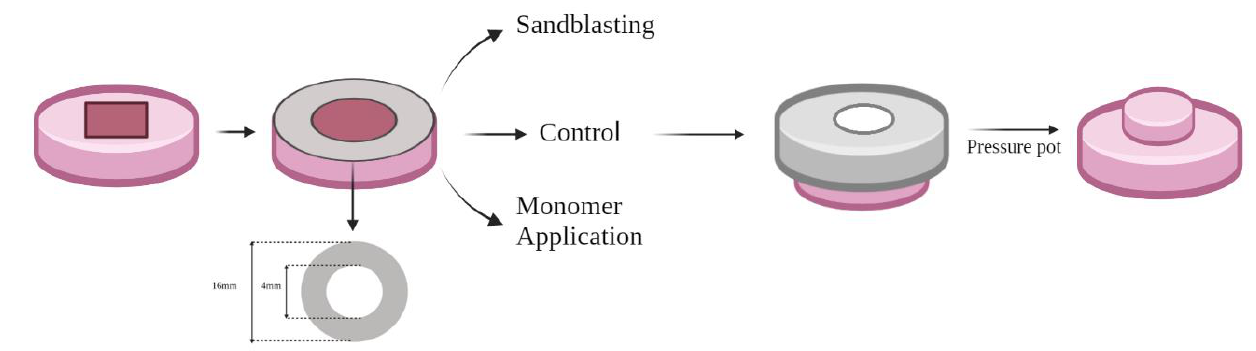
Figure 2. Illustration of the specimen surface treatment and repair procedures ’ standardization .